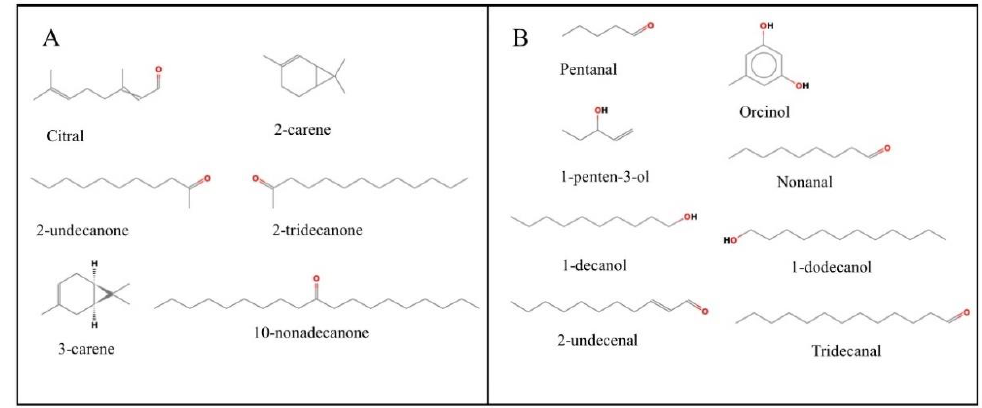
Figure 9. Chemical structures of differential metabolites of Houttuynia cordata . ( A ) Six metabolites from underground parts (roots); ( B ) Eight metabolites from above-ground parts (stems and leaves).